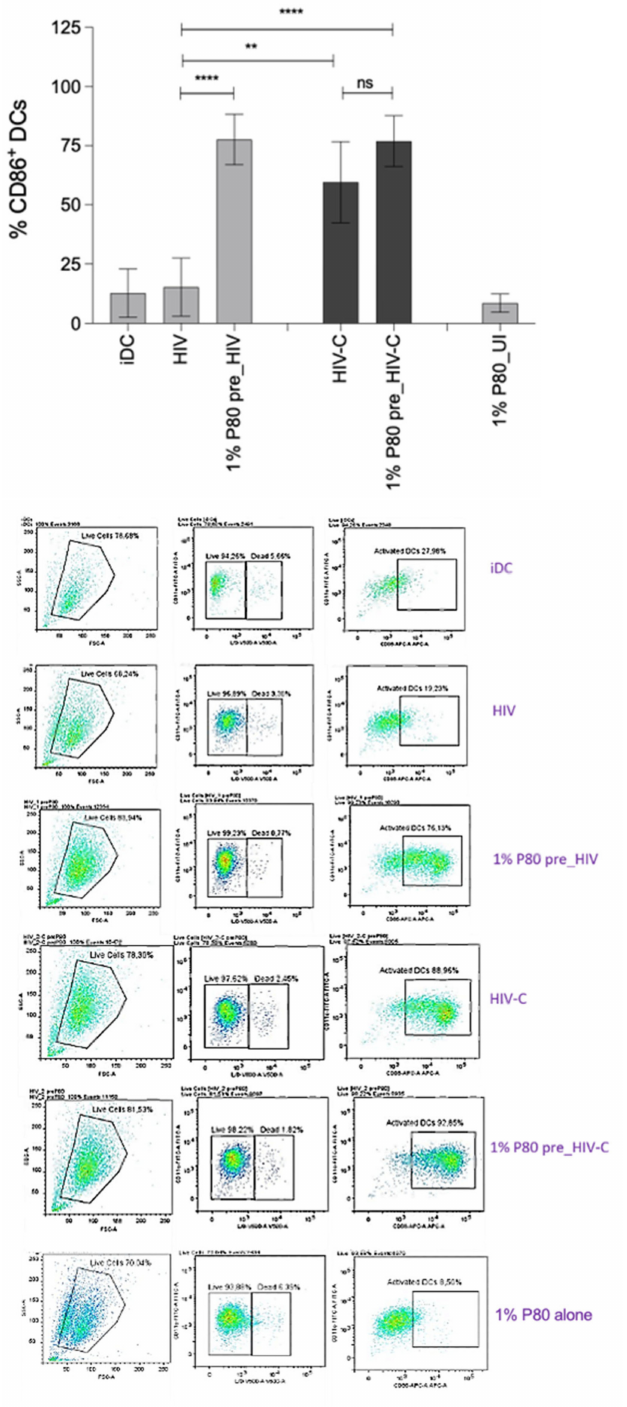
Figure 4. P80 natural essence boosts maturation and co-stimulatory capacity of HIV- and HIV-C-exposed DCs. HIV-loaded DCs illustrate significantly lower CD86 expression compared to HIV-C-exposed DCs (HIV vs. HIV-C). Pre-incubation of DCs with 1% P80 natural essence boosts the co-stimulatory capacity of HIV- (left) and HIV-C-(right) loaded DCs (1% P80 pre_HIV, 1% P80 pre_HIV-C), while in P80-incubated DCs this effect was not observable (1% P80 alone). The upper panel shows a summary of 4 independent donors, the lower one representative donor and the gating strategy. Dead cells were excluded by live/dead staining and activated DCs were gated as CD11chigh/CD86high population. Statistical significance was calculated with GraphPad Prism software and one-way ANOVA with Dunnett’s post-test. ** p < 0.01, **** p < 0.0001. UI,